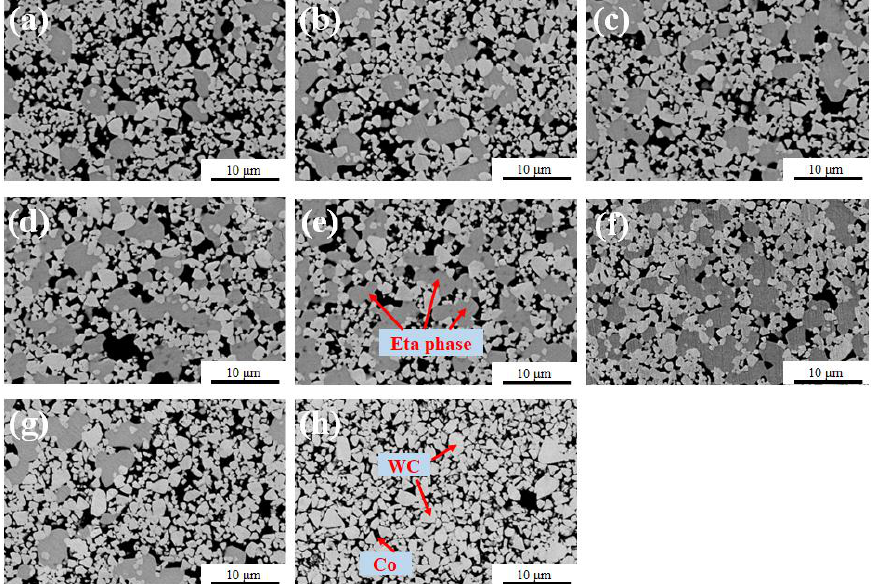
Figure 4. BSE-SEM microstructure of composites, ( a ) 0Fe–5.3C, ( b ) 1Fe–5.3C, ( c ) 2Fe–5.3C, ( d )